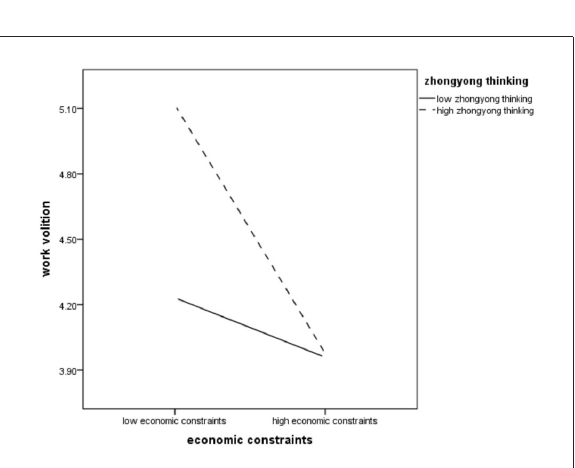
FIGURE3 Zhongyong thinking moderating the relation between economic constraints and work